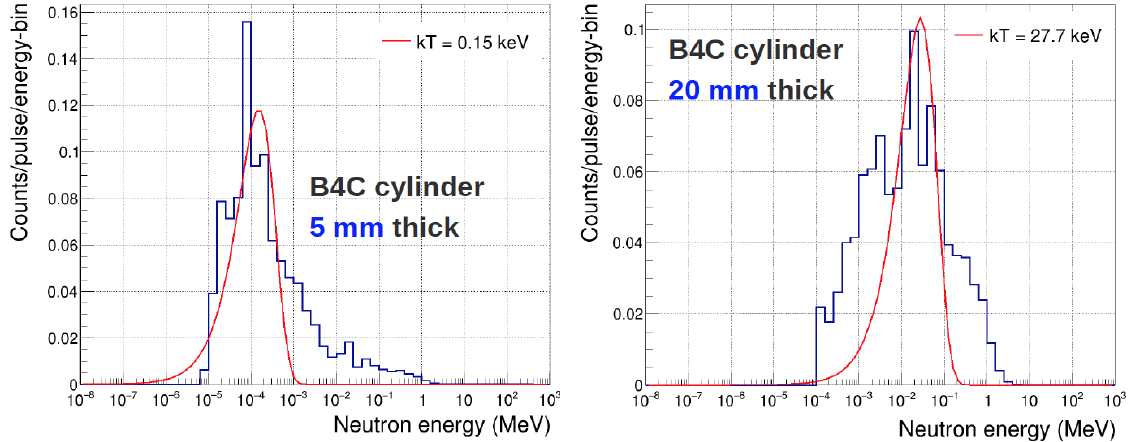
Figure 8. Expected neutron flux shape in the NEAR Station area at the measuring position with 0.5 cm ( left panel ) and 2 cm ( right panel )-thick boron layers, respectively. The spectra are compared to a Maxwellian spectrum of thermal energy kT = 0.15 keV and kT = 27.7 keV